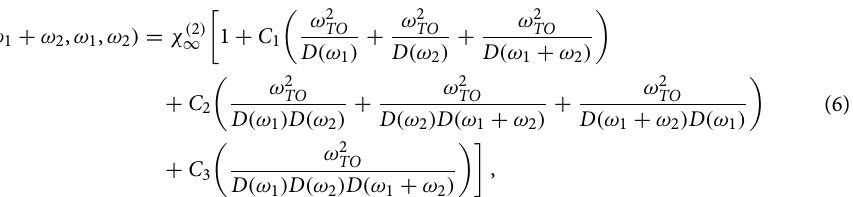
Figure 6. Dispersion of χ